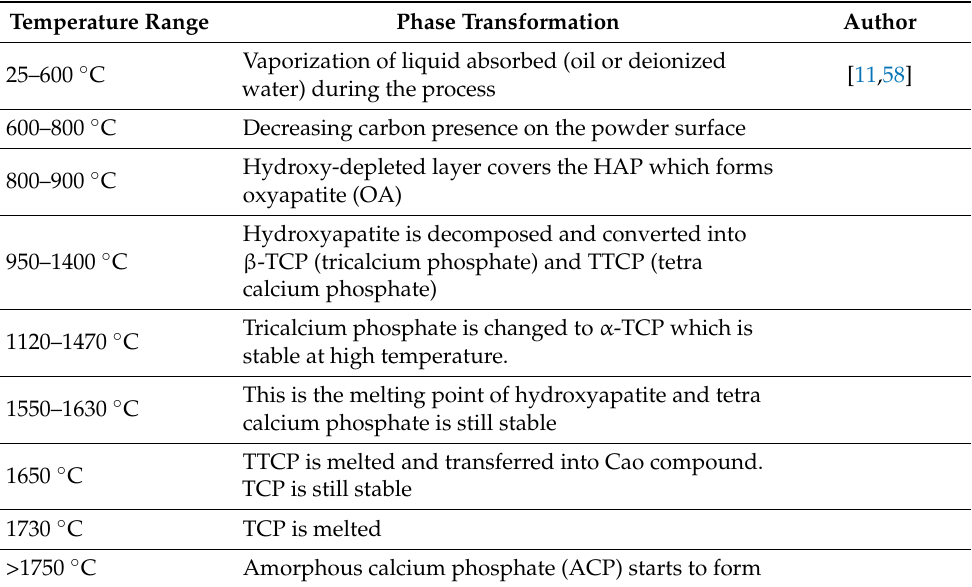
Table 2. Hydroxyapatite powder (HAp) phase transformation with increasing temperature during electrical discharge machining